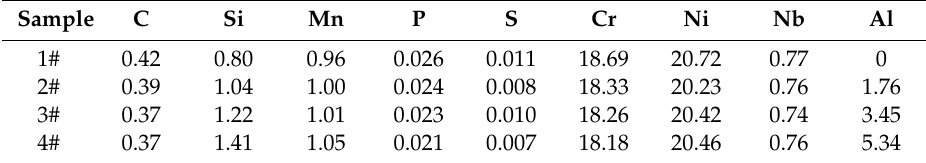
Table 1. Chemical composition of ZG40Cr20Ni20Al x steel